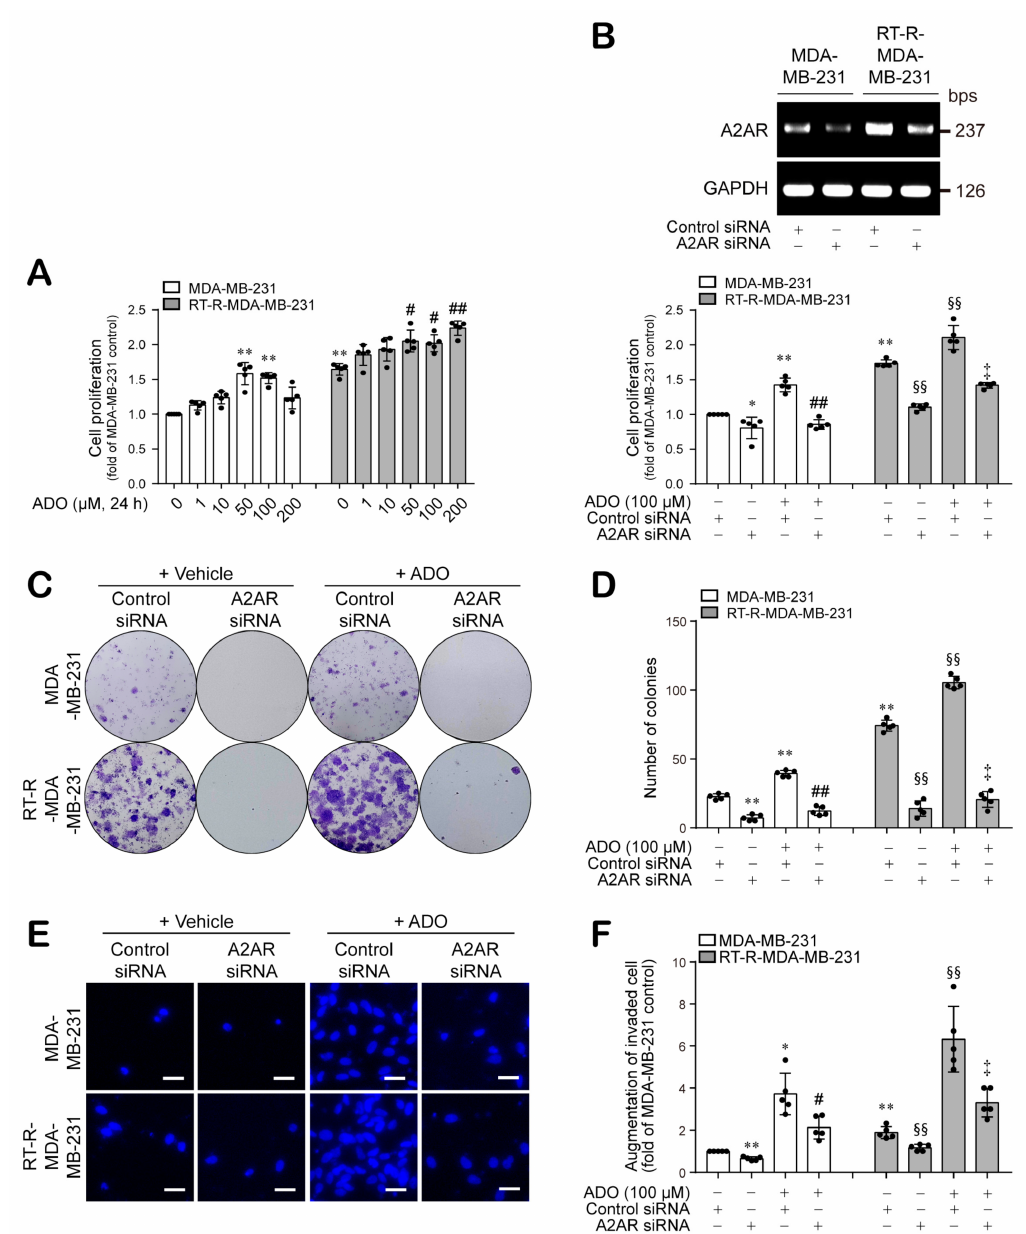
Figure 4. Extracellular ADO increased cell proliferation and colony-forming ability of MDA-MB-231 and RT-R-MDA-MB-231 cells in an A2AR-dependent manner. ( A ) Cells were treated with ADO at indicated doses for 24 h, and the cell proliferation was measured by CCK-8 assay as described in Section 2. ( B ) Cells were transfected with negative control (CTRL) siRNA (100 nM) or A2AR siRNA (100 nM) for 4 h, and then the medium was replaced with fresh complete medium. After 24 h, total RNA was collected, and the efficiency of A2AR siRNA on A2AR expression was determined by RT-PCR. Then, CTRL siRNA- or A2AR siRNA-transfected (100 nM) cells were treated with ADO (100 µ M) for 24 h, and then cell proliferation was measured as above. ( C,D ) CTRL siRNA- or A2AR siRNA-transfected cells were treated with ADO (100 µ M) for 24 h, and then culture medium was discarded and replaced with fresh complete medium every 2–3 days. After 1–2 weeks, colony-forming ability was determined as described in Section 2. ( E,F ) Cells transfected with indicated siRNAs were treated with ADO (100 µ M) for 24 h, and the invasion assay was performed and quantified as described in Section 2. The values represent the means ± SD of 5 independent experiments (scale bar, 100 µ m). * p < 0.05, ** p < 0.01 compared to the control of MDA-MB-231; # p < 0.05, ## p < 0.01 compared to the ADO treatment of MDA-MB-231; §§ p < 0.01 compared to the control of RT-R-MDA-MB-231; ‡ p < 0.01 compared to the ADO treatment of